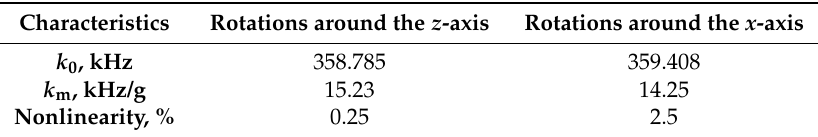
Table 2. The keynote characteristics of the experimental design.